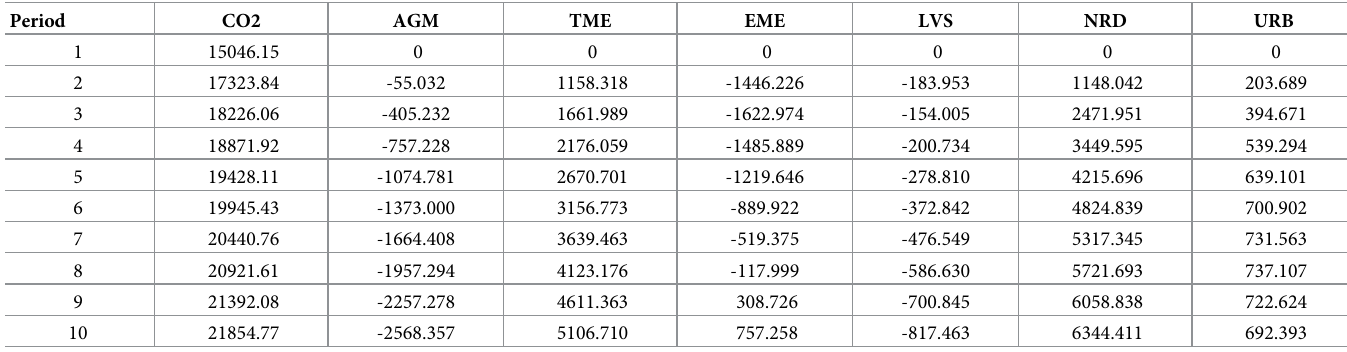
Table 12. IRF estimates of CO2